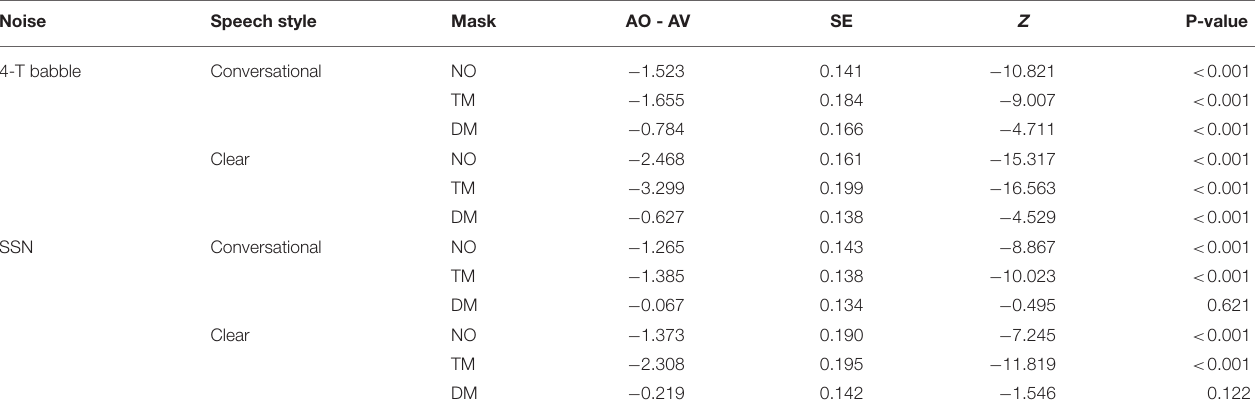
TABLE 5 | The contrast of presentation modes (audio-only, AO and audiovisual, AV) in each face mask condition, background noise, and speaking style.